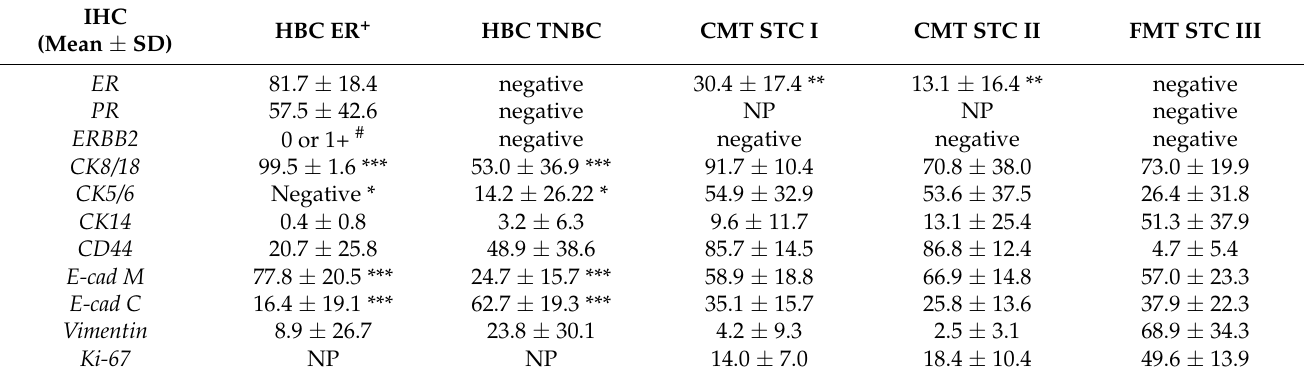
Table 2. Immunohistochemistry results in human (HBC), canine (CMT), and feline (FMT) mammary cancer represented as mean ± standard deviation (SD) of percentage of positive cells. Statistics refers to the comparison of the expression of a specific marker between groups of the same species.